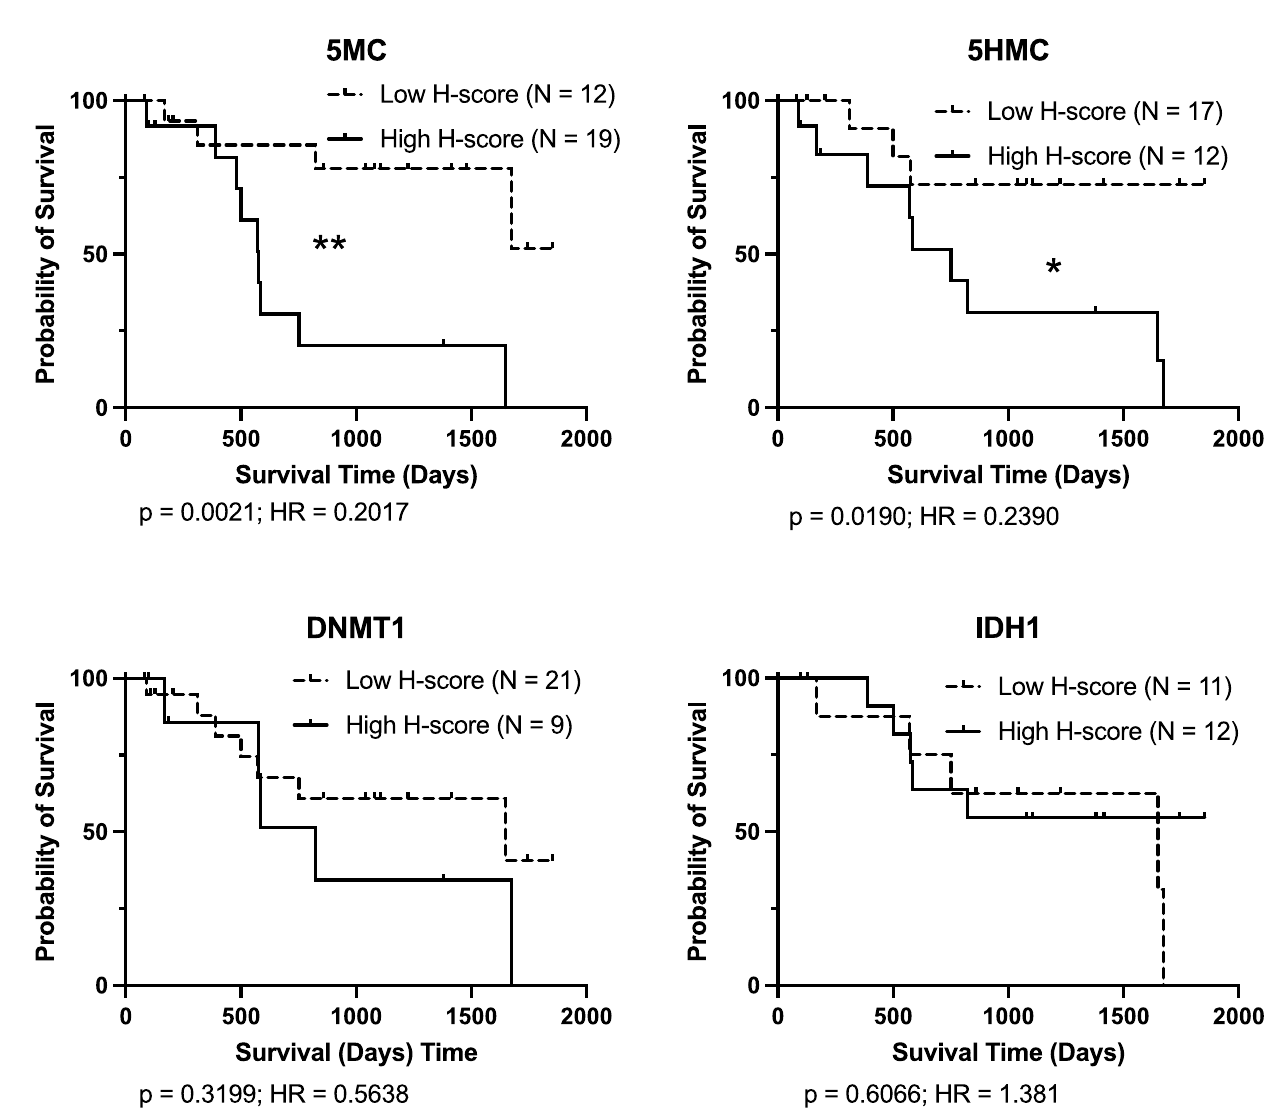
Fig 6. Kaplan-Meier survival curves for OS for Patnaik’s grading system grade II cases. Logrank analysis indicates comparisons showing significant differences (p < 0.05). Cases lost to follow-up, still healthy at last follow-up, or that died of causes unrelated to MCT disease are indicated by upward ticks on the curves, and were right-censored for